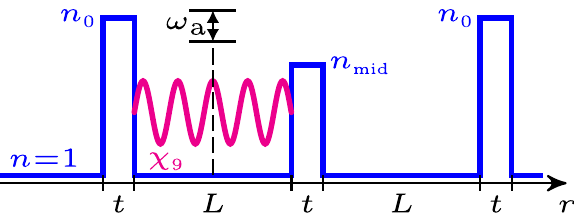
FIG. 10. One-dimensional double cavity potential. The Q -space basis modes are chosen as solutions of the Dirichlet problem in the left cavity (the figure shows mode χ 9 in magenta as an example). This choice of basis appears particularly suitable for describing local light-matter interactions in the left cavity but not in the right cavity. An atom is placed at the center of the left cavity, chosen resonant with the ninth cavity